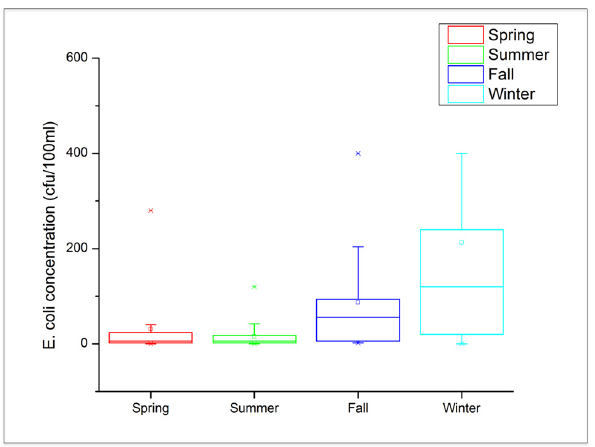
Figure 8. The relationship between E. coli population and temperature in the effluent of Pond 1.